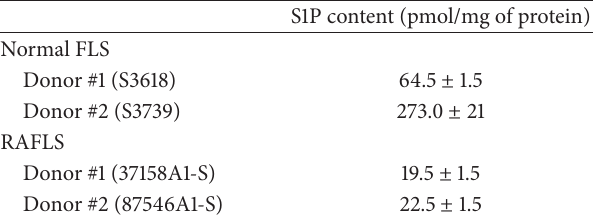
Table 1: S1P content in normal FLS and